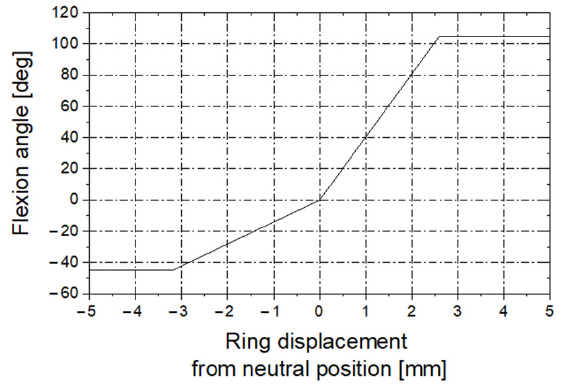
Figure 10. Calibration function: ring displacement vs. deflection of the guide tip.